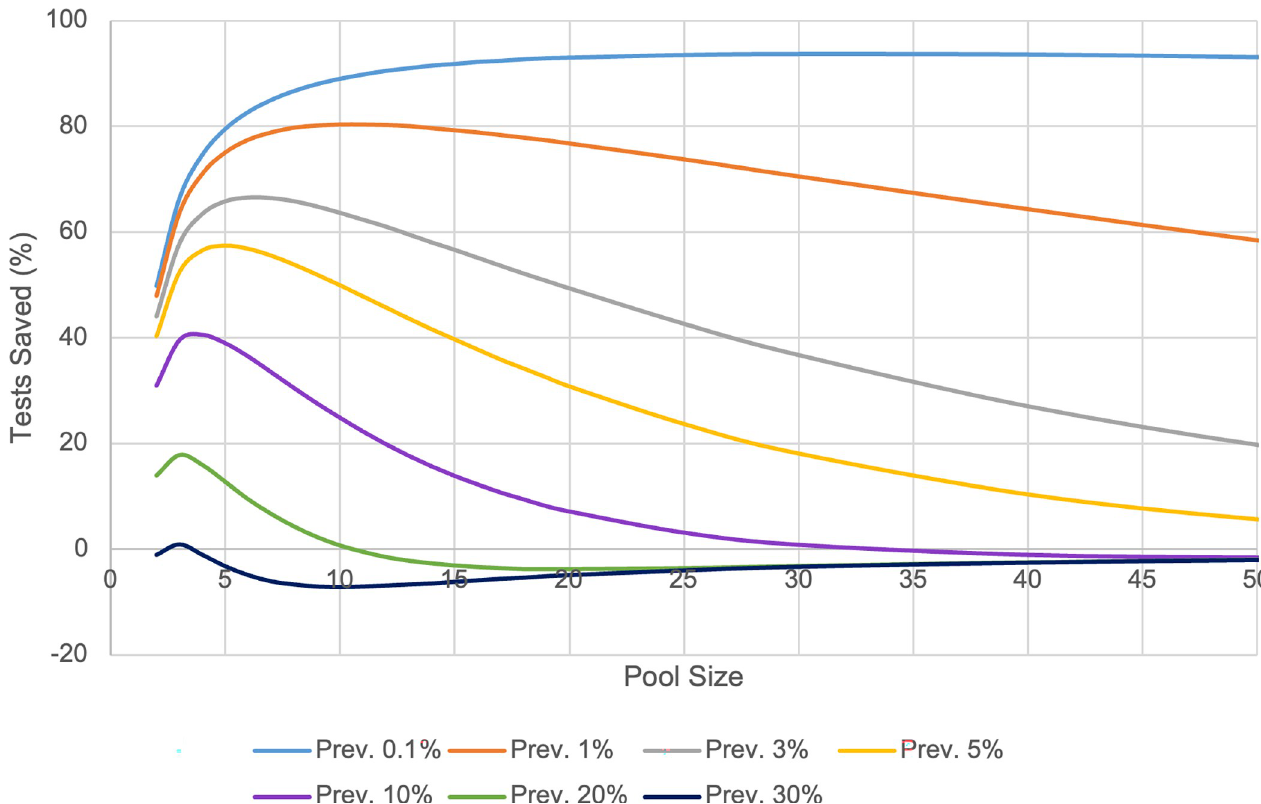
Fig 4. Test efficiency of Dorfman pooling. The efficiency of utilizing Dorfman pooling at varying pool sizes adapted to positivity prevalence compared to individual testing. A positive value for tests saved represents a reduction in tests used compared to individual testing, and negative values represent an increase in the number of tests